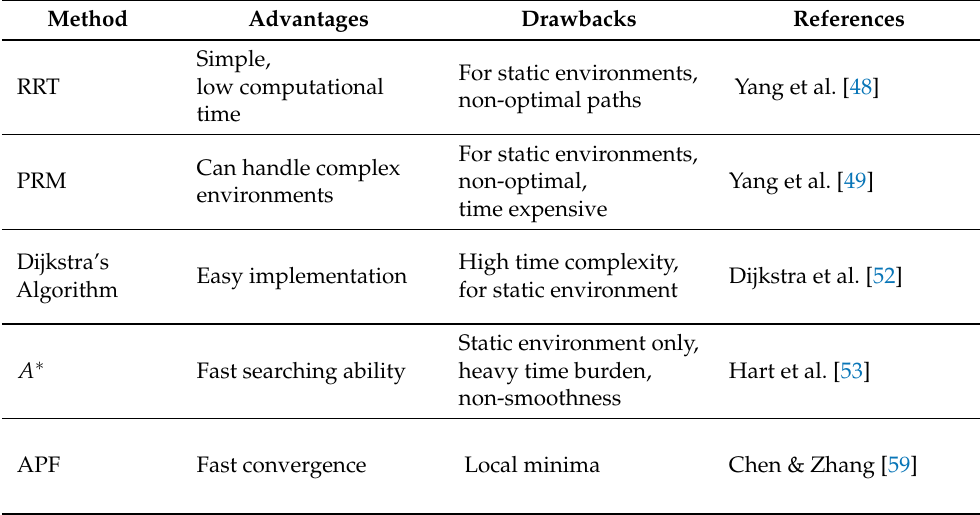
Table 1. Advantages and disadvantages of contemporaneous path-planning